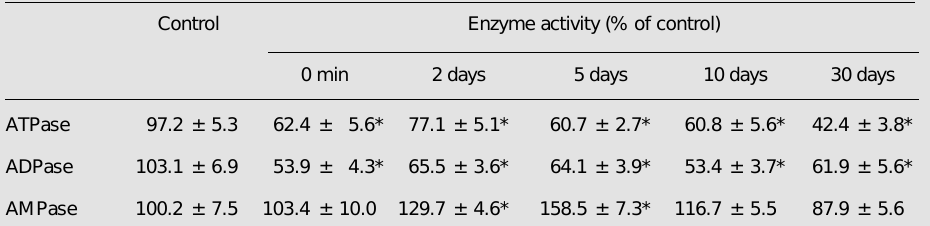
Table 1 - Activity of platelet ATP diphosphohydrolase (ATPase and ADPase activities) and 5'-nucleotidase (AMPase activity) after 10 min of brain ischemia followed by 0 min, and 2, 5, 10 and 30 days of reperfusion. Results are reported as percentage of control activity (ATPase: 11.2 ± 0.71; ADPase: 5.9 ± 0.36; AMPase: 1.8 ± 0.10 nmol Pi released min -1 mg protein -1 ). Data are reported as means ± SEM for 7 to 9 different platelet preparations assayed in duplicate. *P<0.05 compared to control group (analysis of